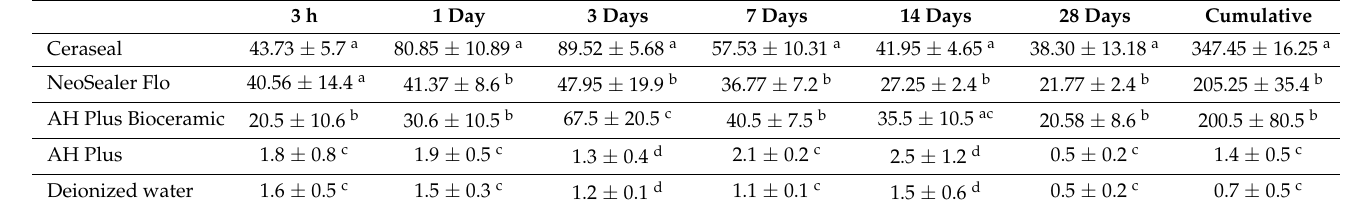
Table 5. Calcium release (ppm, mean ± SD; n = 8) of tested sealers. Calcium release in soaking water was measured after immersion of set materials (+100% of final setting time). Different letters indicate statistically significant differences ( p < 0.05) among